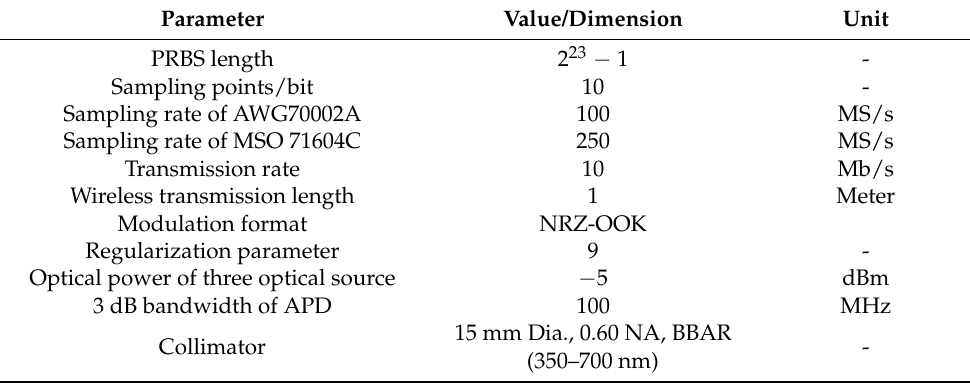
Table 1. Experimental parameters and optical/electrical